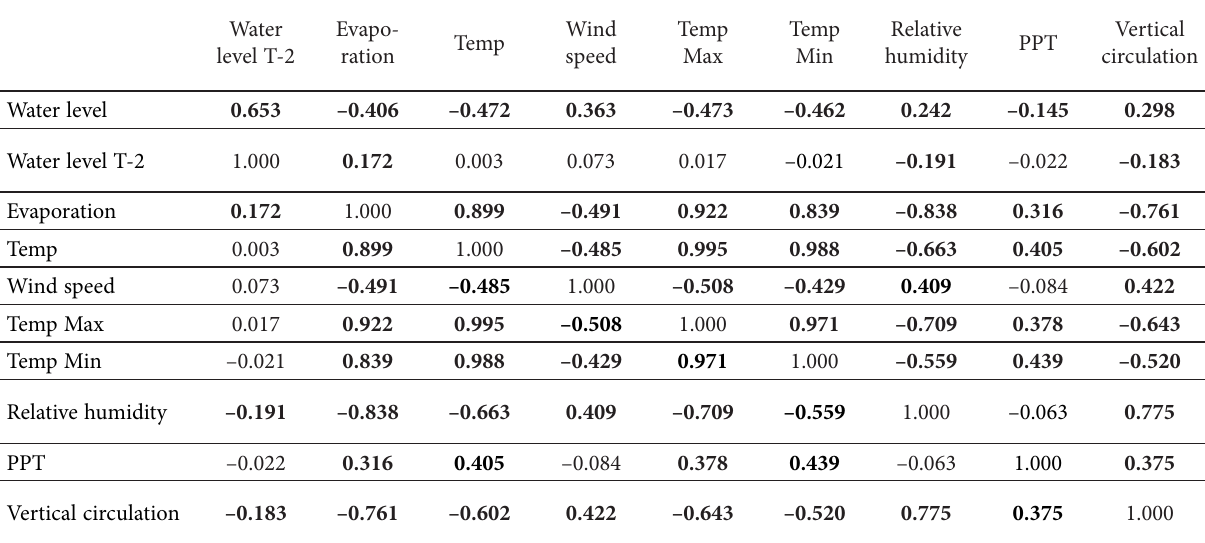
Table 3. Coefficient of correlation matrix for two-month-lagged exogenous variables, bold font indicated correlation coefficients which exhibit statistical significance. Presented abbreviations are coherent with those presented in Table 2